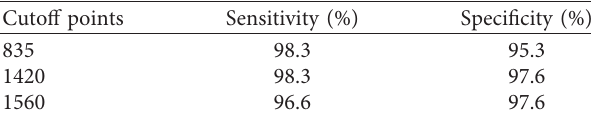
Table 4: Sensitivity, specificity, and diagnostic accuracy at different cutoff levels of salivary LDH.